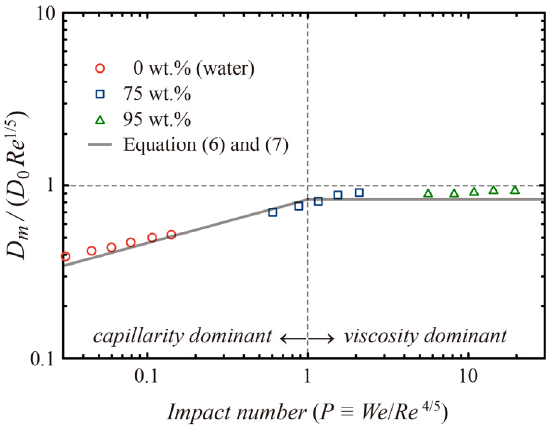
Figure 2. Model validation based on the maximum spreading diameter obtained from single-phase drop impact on non-wettable flat surfaces.